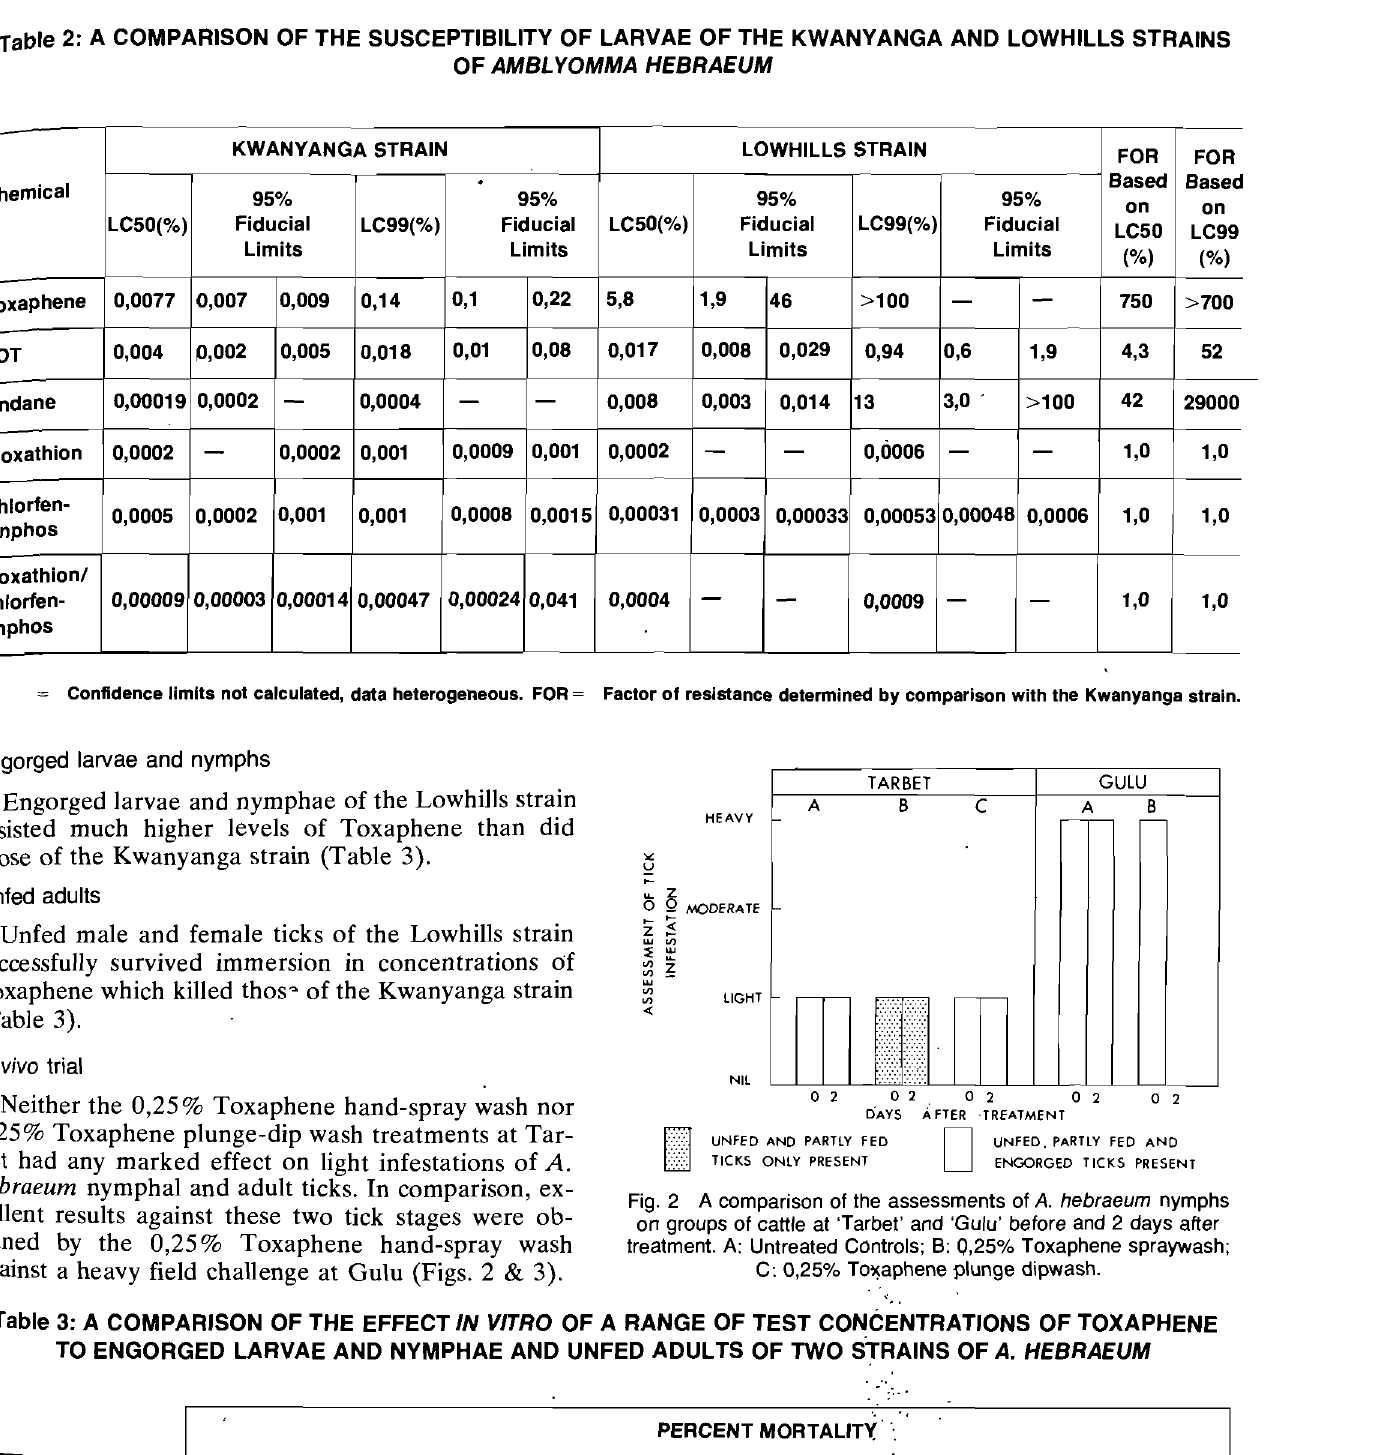
OF AMBLYOMMA HEBRAEUM